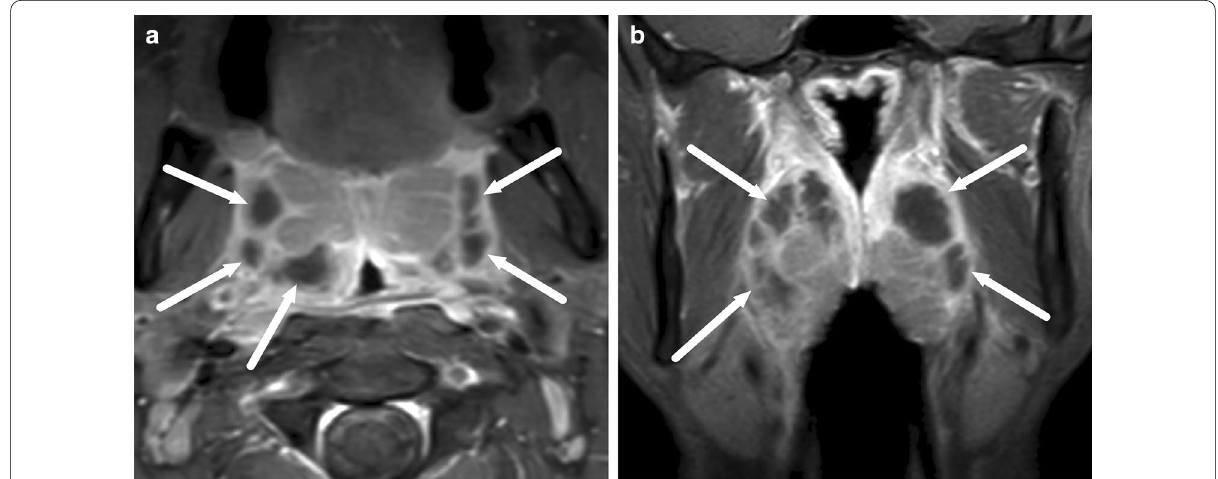
Fig. 15 A case of multi-locular bilateral PTAs on axial ( a ) and coronal ( b ) fat-suppressed post-contrast T1-weighted images as indicated by